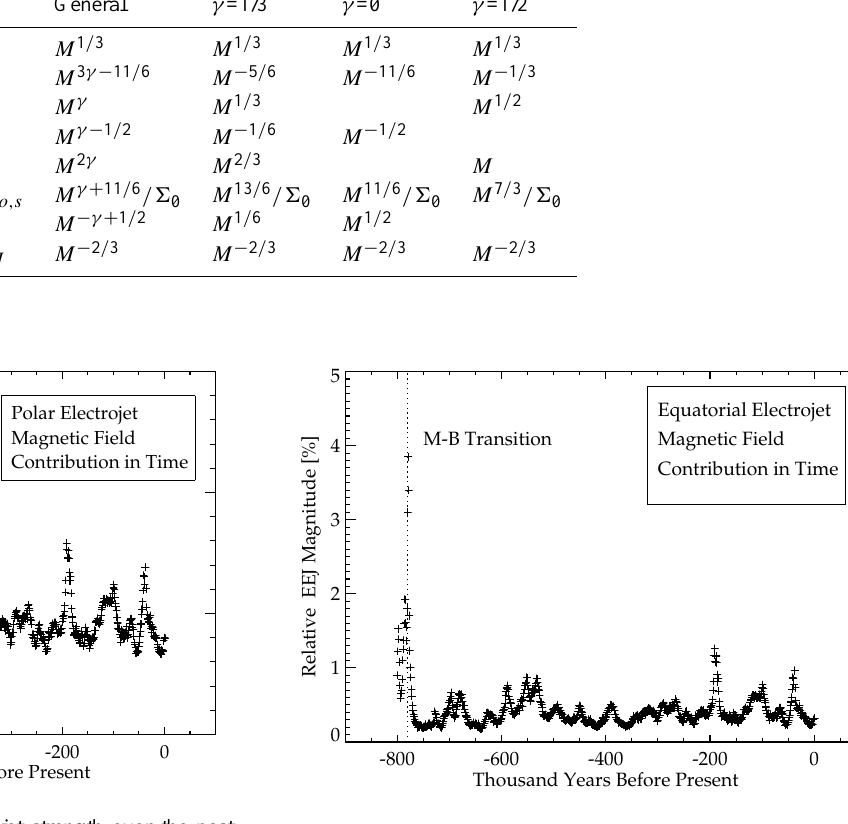
Fig. 6. Estimated relative equatorial electrojet strength over the past 800000